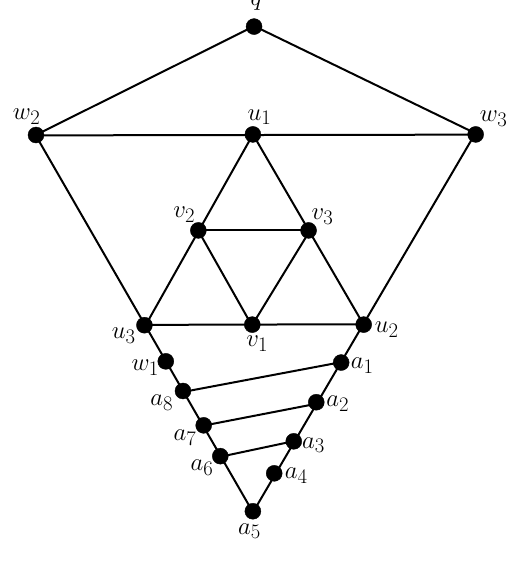
Figure 3: The graph H 18 ,E